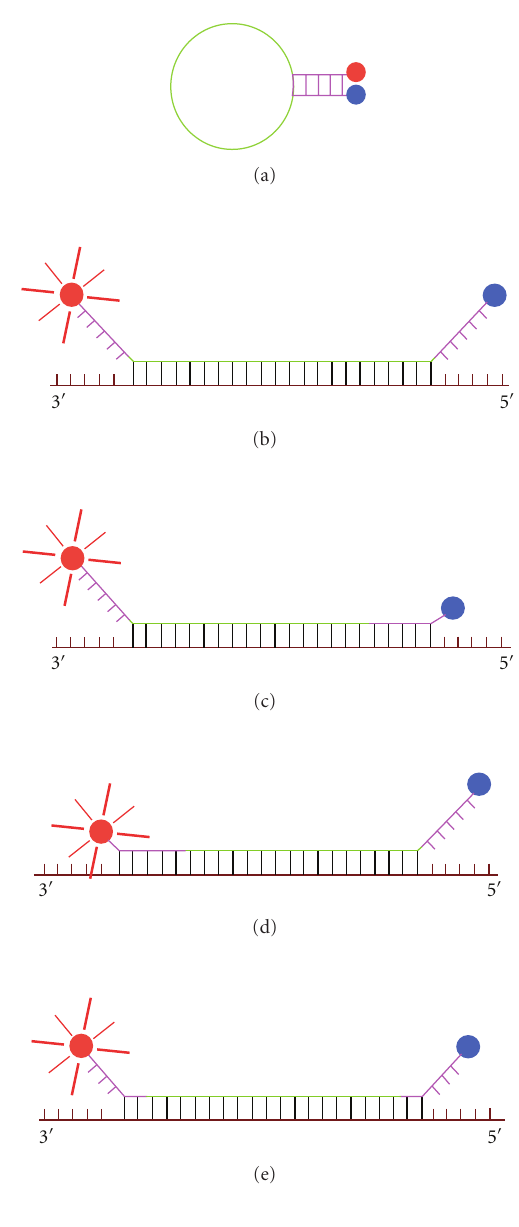
Figure 2: Di ff erent positions for MB-target hybridization. The loop region is illustrated in green and the stem in purple for all panels, target is brown and the bonds MB target are black ((b), (c), (d) y (e)). (a) MB with a stem of five nucleotides in the stem-loop hairpin conformation. (b) MB with a stem of five nucleotides and twenty two nucleotides in the loop, target hybridization occurs only at loop region. (c) MB with a stem of five nucleotides and a stem of seventeen nucleotides, using the loop and all the 3 (cid:2) arm to hybridize the target (3 (cid:2) shared stem MB). (d) MB with a stem of five nucleotides and a loop of seventeen nucleotides, using the loop and completely the 5 (cid:2) arm to hybridize its target (5 (cid:2) shared stem MB). (e) MB with a stem of five nucleotides and loop of eighteen nucleotides using partially both arms to hybridize its target (two nucleotides of every arm). Notice that a target that makes possible the design of a MB that hybridizes it using completely both arms could have a strong secondary structure that makes impossible the MB-target